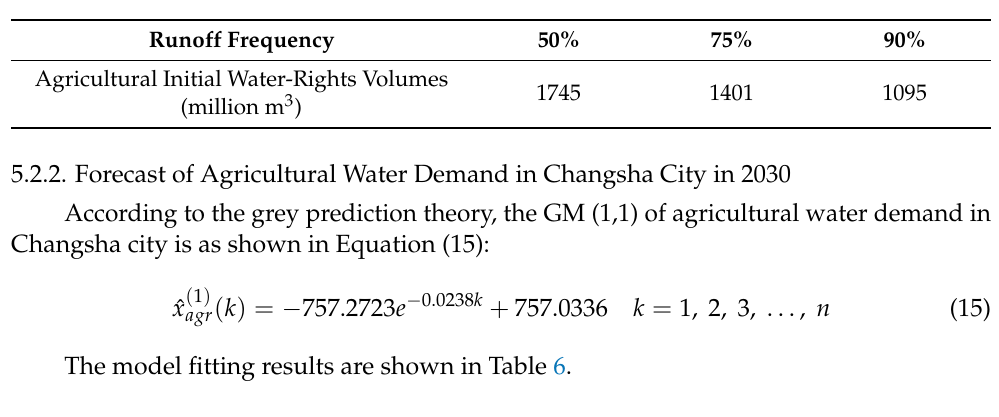
Table 5. The agricultural initial water rights of Changsha city under different runoff frequencies in